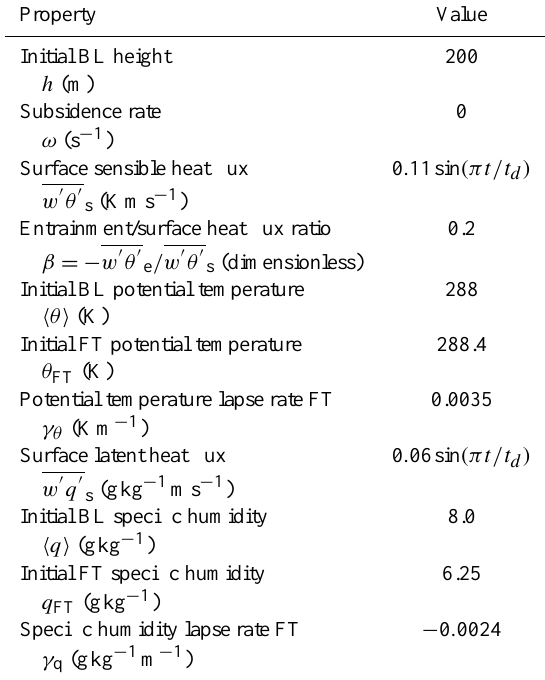
Table 4. The initial and boundary conditions in boundary layer (BL) and free troposphere (FT) as obtained from fitting MXLCH-SOA to the case study observations. All initial conditions are imposed at 07:50LT. Heat fluxes are applied from 07:50 to 18:50LT with H = ρc p w 0 θ 0 s and LE = ρL v w 0 q 0 s . t is the time (s) and t d the length of the simulation (s). The subscripts s and e indicate values at the surface and the entrainment zone,